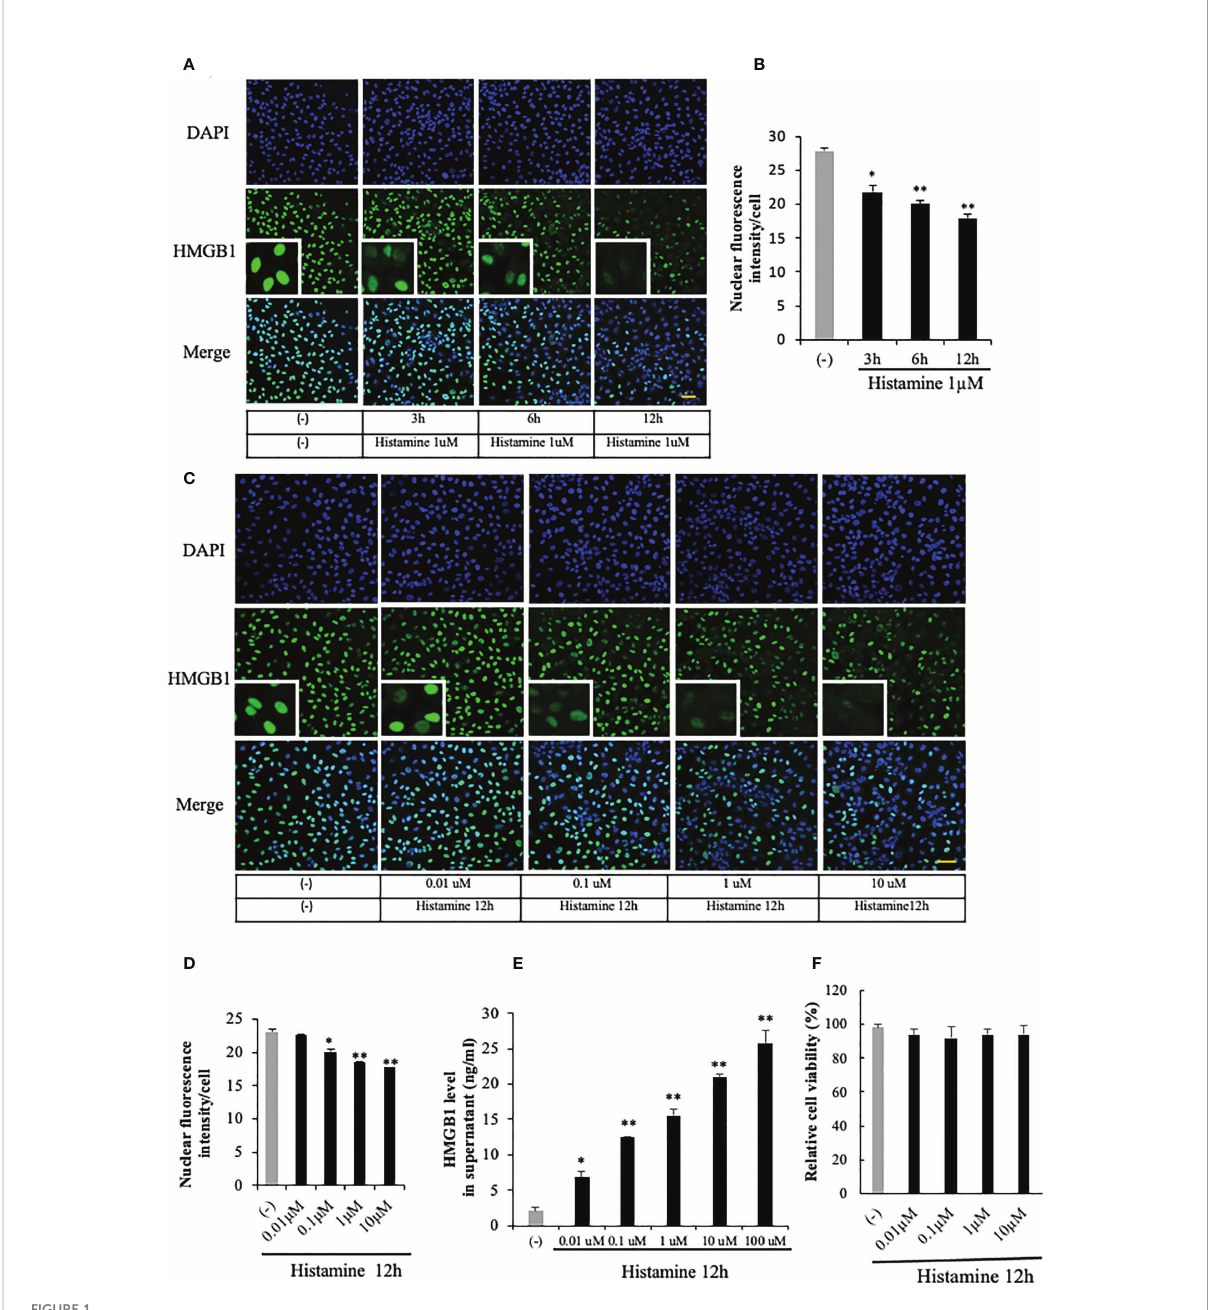
FIGURE 1 HMGB1 translocation and release from VECs after histamine stimulation. (A) EA.hy 926 endothelial cells were stimulated with histamine (1 m M) for the periods indicated. HMGB1 was observed by immunostaining with green fl uorescence and cell nucleus was observed by blue fl uorescence after staining with DAPI. Scale bar=10 m m, (n=5 per group). (B) The translocation of HMGB1 was quanti fi ed by the residual presence of the HMGB1 (green fl uorescence) in the cell nucleus in each cell. The results were quanti fi ed by ImageJ software and are expressed as the ratio of total nuclear HMGB1 intensity/cell numbers. (C , D) EA.hy 926 cells were stimulated with the indicated concentrations of histamine for 12 h, and the HMGB1 in the nucleus was determined by the immunostaining (n=5 per group). (E) Endothelial cells were cultured for 12 h with different concentrations of histamine. The cell culture medium was collected and analyzed for HMGB1 release by ELISA. All results are the means±SEM of fi ve different experiments. (F) Effects of histamine on the viability of EA.hy 926 cells. EA.hy 926 cells were stimulated with different concentrations of histamine for 12 h. The cells were then incubated with MTT at 37°C for 4 h by adding 10 m l of 5 ng/ml MTT solution to each well. After removal of the cell supernatant, 200 m l of DMSO was added to each well to dissolve the crystals. The OD value was recorded using a microplate reader at 570 nm wavelength. All results are the means±SEM of three different experiments, (n=5 per group). Statistical analyses were conducted by one-way ANOVA followed by the post hoc Fisher test. *p<0.05, **p<0.01 vs. control in the absence of